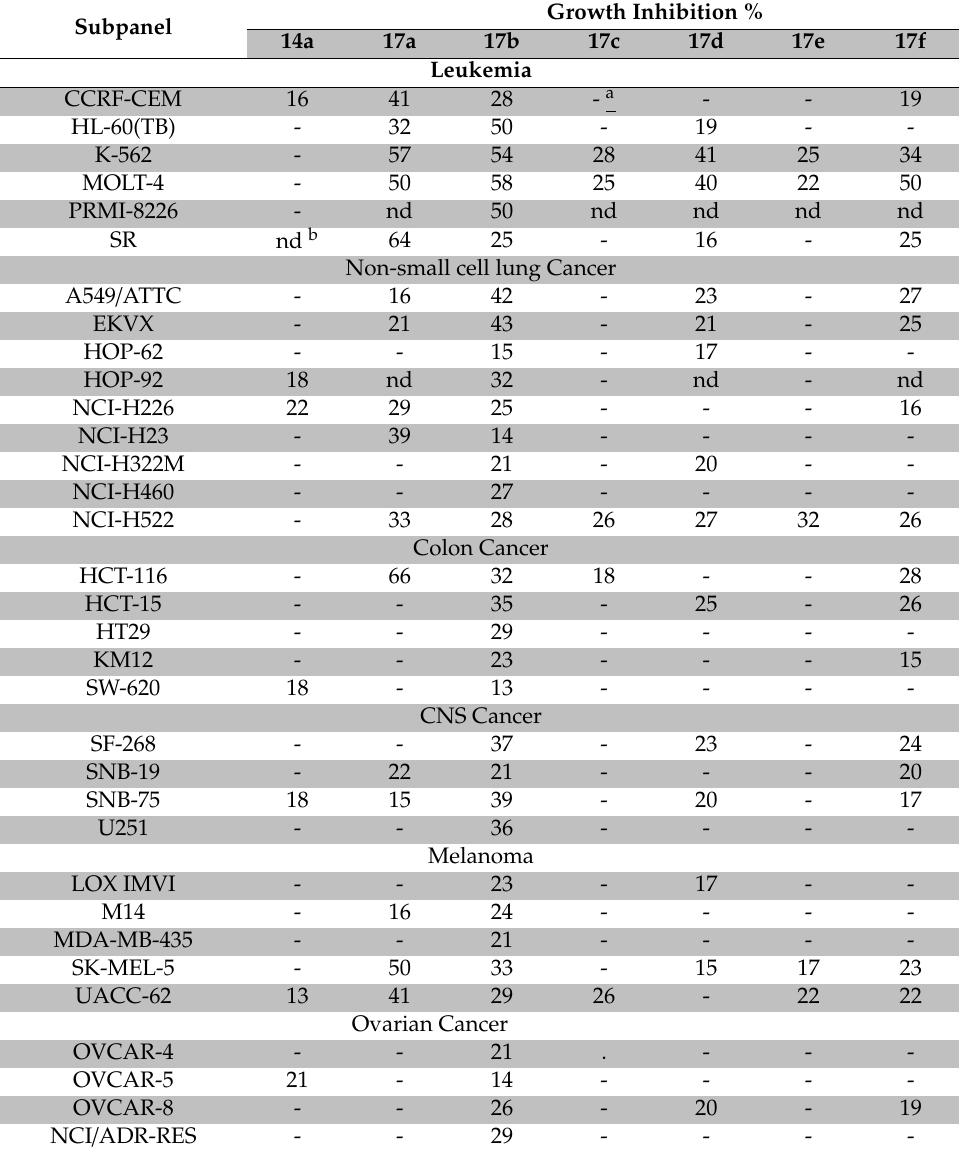
Table 2. In vitro growth inhibition % (GI%) of some selected 1,2-disubstituted benzimidazoles against a panel of tumor cell lines at 10 µ